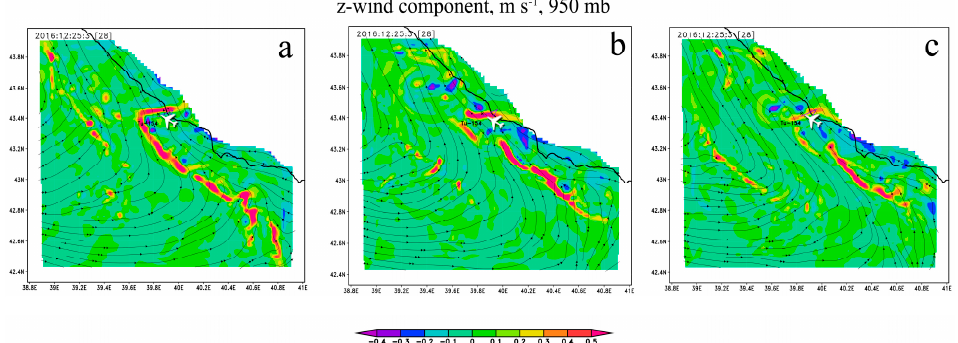
Figure 4. The Tu-154 crash site, Russia, 2016. The z-wind speed for three types of local mixing conditions near the surface: in the absence of local mixing ( a ); the five-layer model of thermal diffusion ( b ); thermal diffusion with additional SST assimilation ( c ).